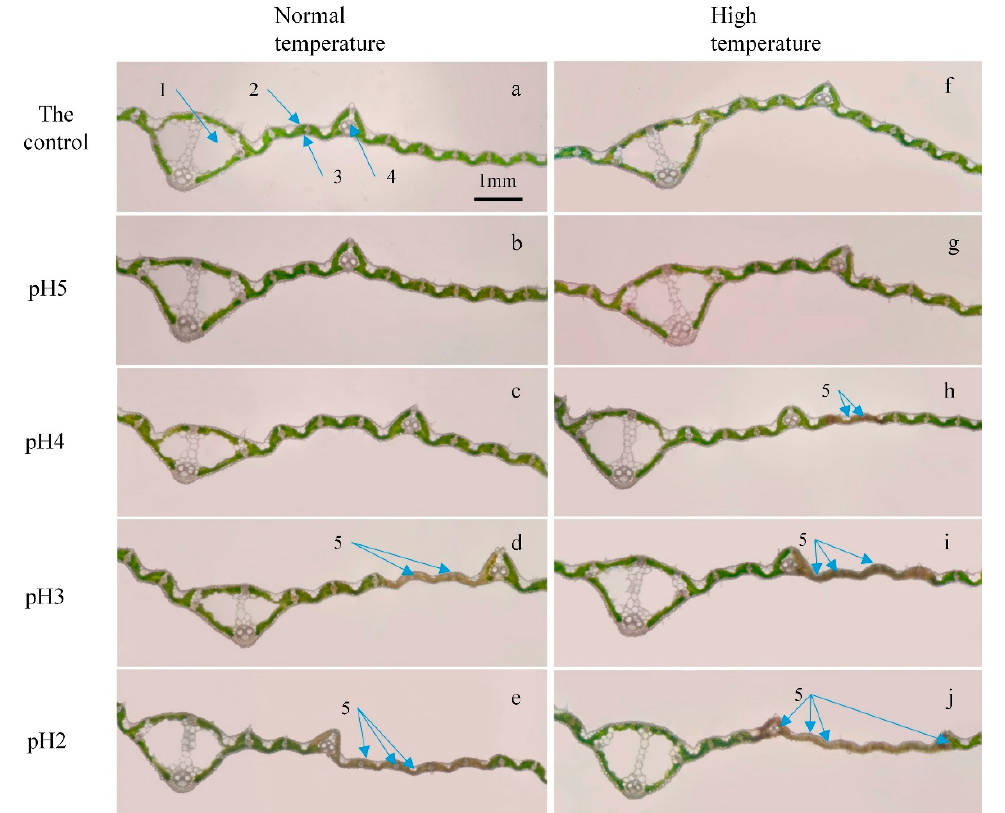
Figure 6. Longitudinal sections of rice leaves treated with different pH acid rain for 7 days under normal– and high– temperature conditions. ( a – e ) The leaves subjected to normal temperature treatment. ( f – j ) The leaves subjected to high temperature treatment. ( a , f ) The leaves with the control (pH 7) treatment. ( b , g ) The leaves with pH 5 acid rain treatment. ( c , h ) The leaves with pH 4 acid rain treatment. ( d , i ) The leaves with pH 3 acid rain treatment. ( e , j ) The leaves with pH 2 acid rain treatment. Labels in microscopic image: 1, major longitudinal vein; 2, upper epidermis; 3, lower epidermis; 4, minor longitudinal vein; 5, injury spots .